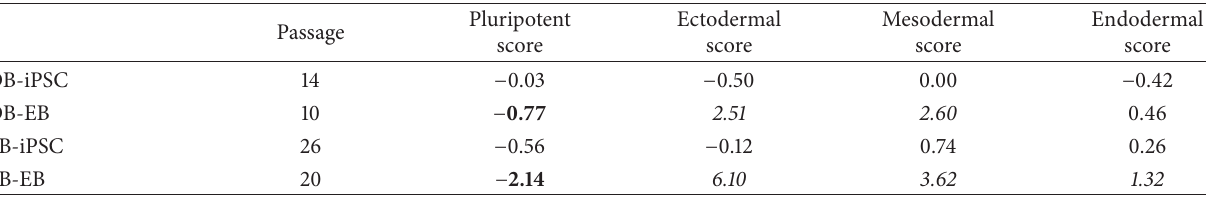
Table 1: Scorecard analysis of induced pluripotent stem